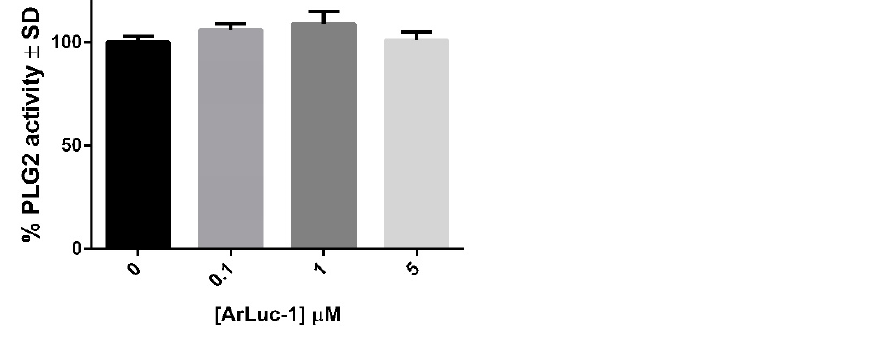
Figure 4. PLG2 activity in presence of the indicated concentrations of ArLuc-1. Error bars represent mean ± SD.